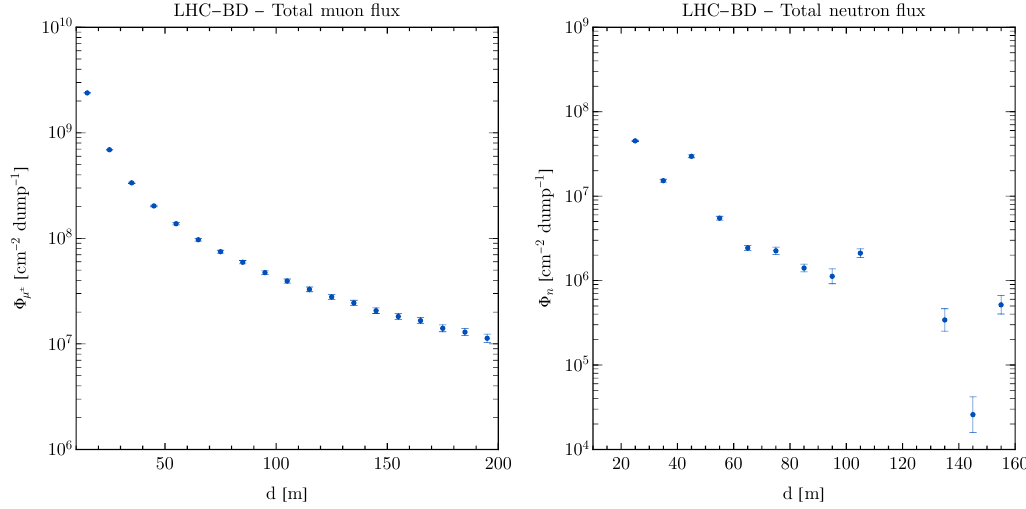
Figure 12. Total muon (left) and neutron (right) fluxes per cm 2 per beam dump as function of the distance to the main LHCBD cavern in the forward